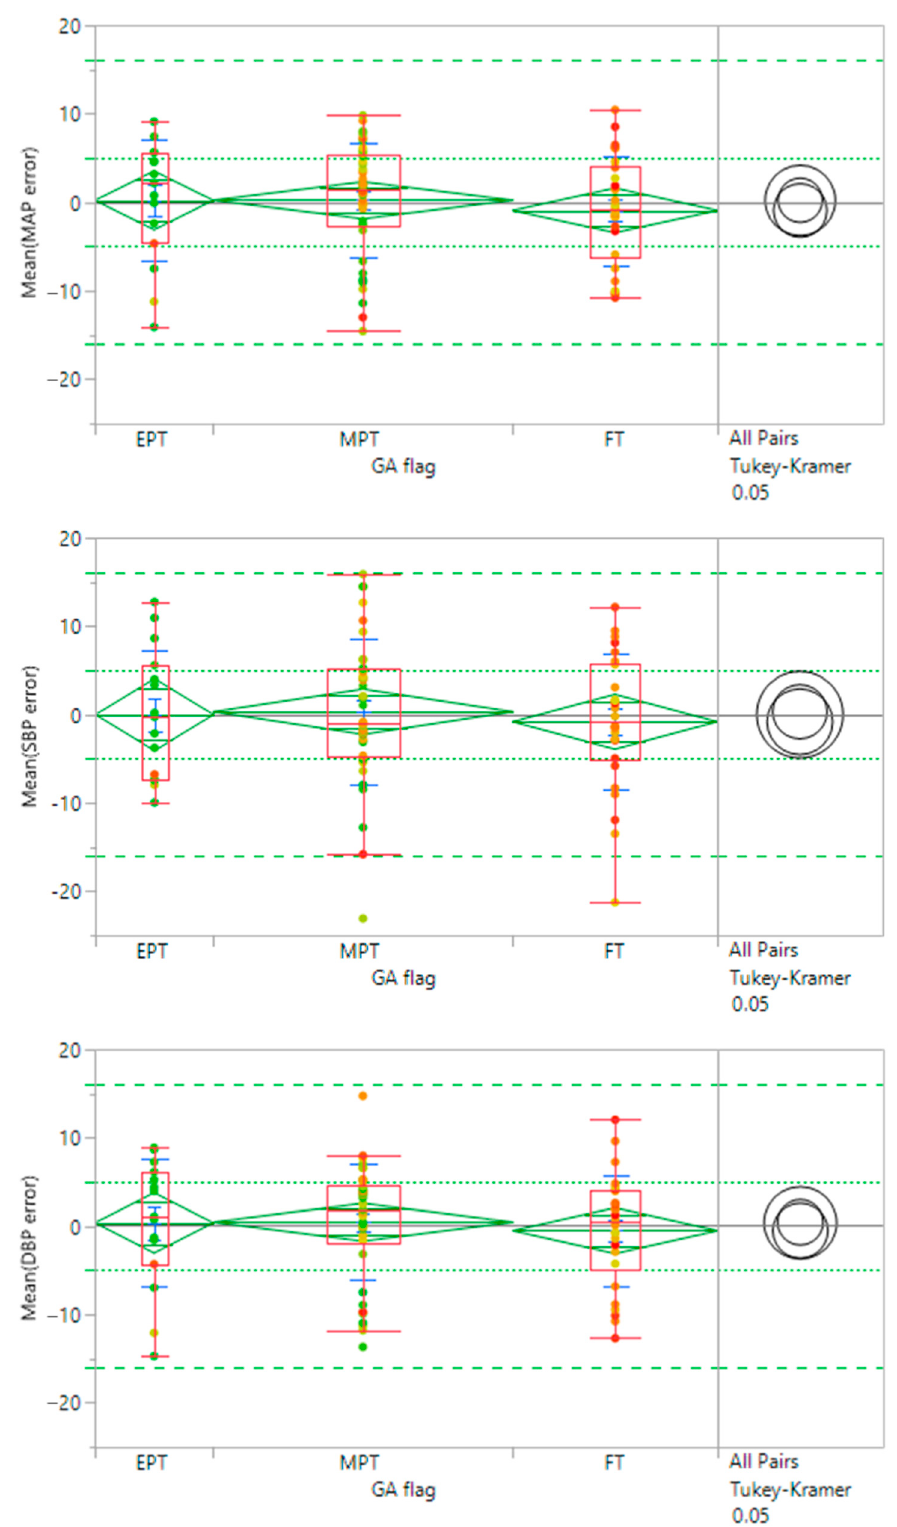
Figure 5. Effect of gestational age (GA) on efficacy. Groups categorized by prematurity are com- pared through mean diamonds (green) and Tukey–Kramer circles (black). EPT (<28 wks GA), MPT (28–37 wks GA), FT ( ≥ 38 wks GA). Overlap between diamonds and circles indicates there is no significant difference between groups. Mean diamonds are contained within the FDA guidelines for accuracy (dotted green lines). Targets for 95% confidence levels are indicated with dashed green lines. Points are color-coded by patient